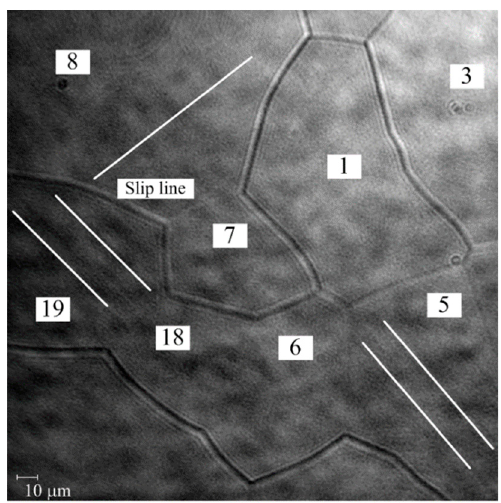
Figure 9. Digital holographic-microscope intensity image of grains 1, 3, 5, 6, 7, 8, 18, and 19, at P = 635